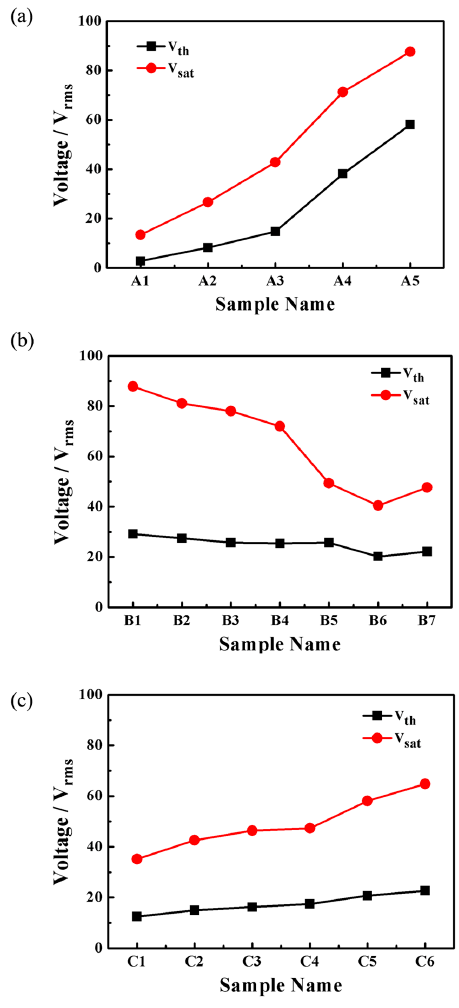
Figure 6. ( a ) Threshold voltage ( V th ) and saturation voltage ( V sat ) of samples A1 – A5 ; ( b )